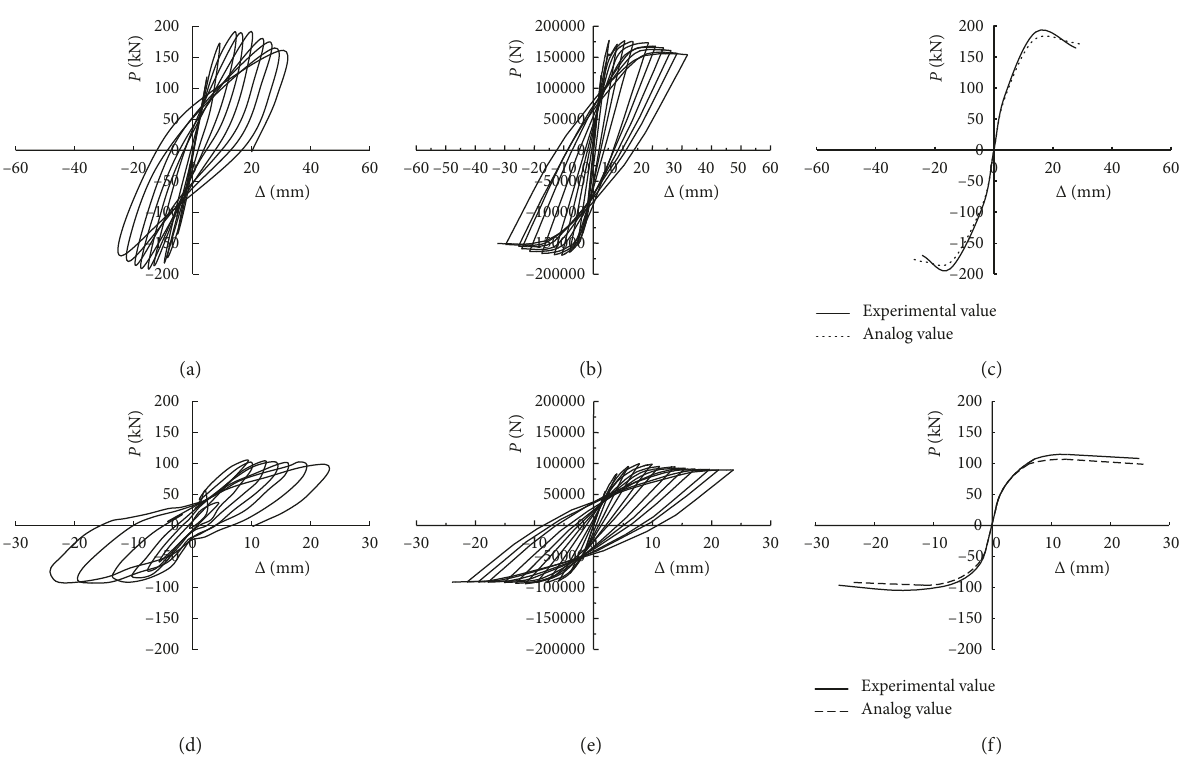
Figure 5: Hysteresis curves of +Z-1 and TZ-2. (a) +Z-1 test hysteresis curve. (b) +Z-1 simulated hysteresis curve. (c) +Z-1 skeleton curve comparison. (d) TZ-2 test hysteresis curve. (e) TZ-2 simulated hysteresis curve. (f) TZ-2 skeleton curve